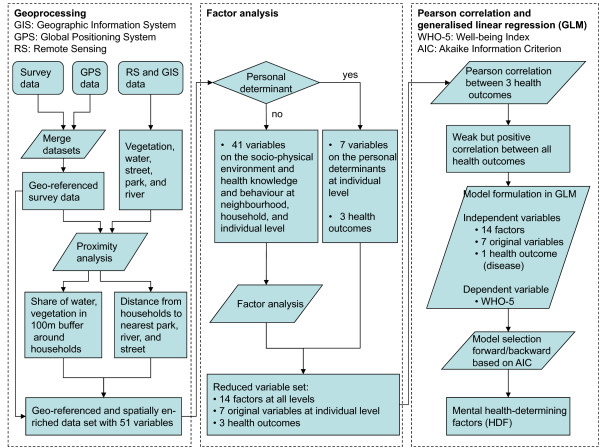
Geo-epidemiological approach used for this study. Parallelograms stand for geoprocessing or statistical processes, rhombuses for selection criteria and rectangles for outcomes. Note that levels were used only for conceptualising the socio-physical environment. All variables were available on the individual level, i.e. for each respondent separately and no aggregation to higher levels was done in order to prevent information loss.